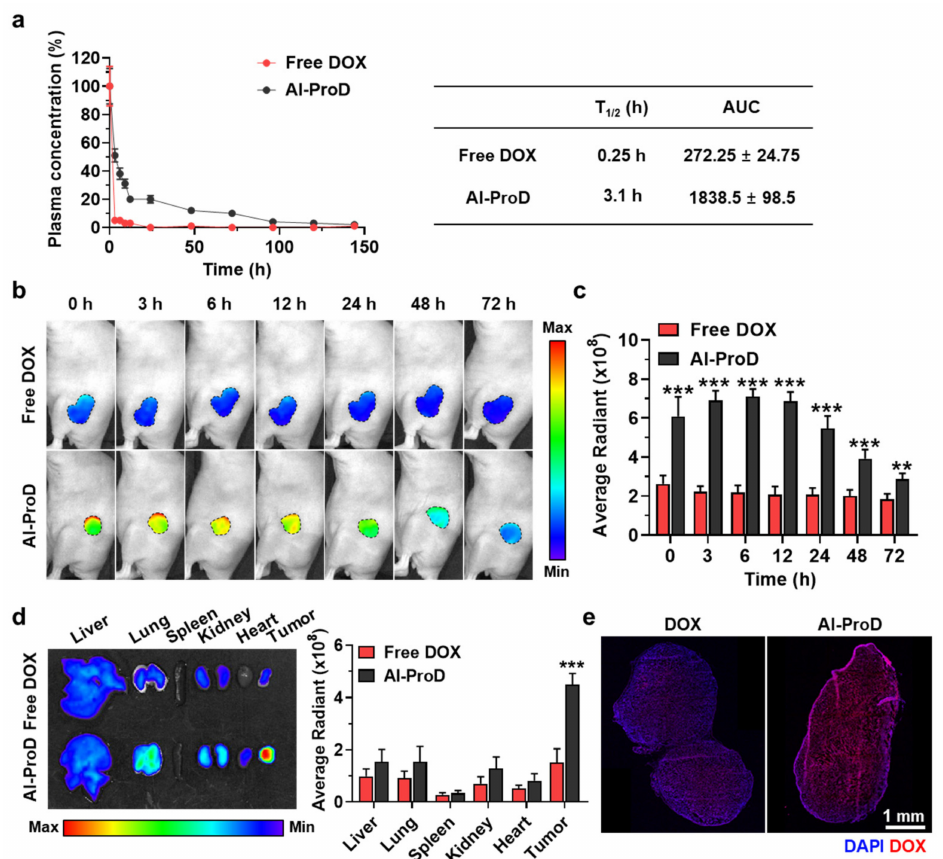
Figure 4. Pharmacokinetics and biodistribution of Al-ProD. ( a ) PK profiles of Al-ProD and free DOX. Area under the curve (AUC) was calculated by Origin 2020 software. ( b ) NIRF images of MDA-MB231 tumor-bearing mice treated with Al-ProD of free DOX. ( c ) Quantification analysis on the DOX fluorescence at tumor tissues in NIRF images. ( d ) Ex vivo imaging of organs from mice treated with Al-ProD or free DOX after 12 h injection. ( e ) Quantification analysis of the DOX fluorescence at major organs in ex vivo imaging. ( e ) Fluorescence images of whole tumor tissues after 12 h of Al-ProD or free DOX treatment. Significance (** p < 0.01, *** p < 0.001) was determined by Student’s t -test ( c , d